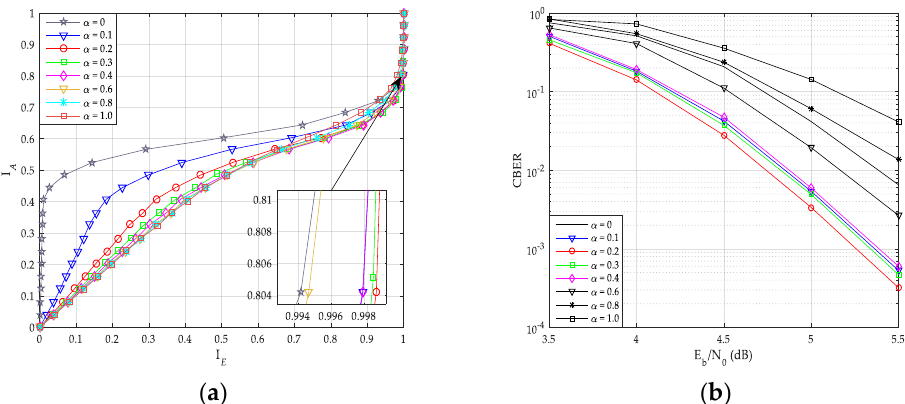
Figure 9. Performance of systematic polar code with SCAN decoder. ( a ) Transfer characteristics; ( b ) code block error rate (CBER) of PC-SCMA over additive white Gaussian noise (AWGN) channel.